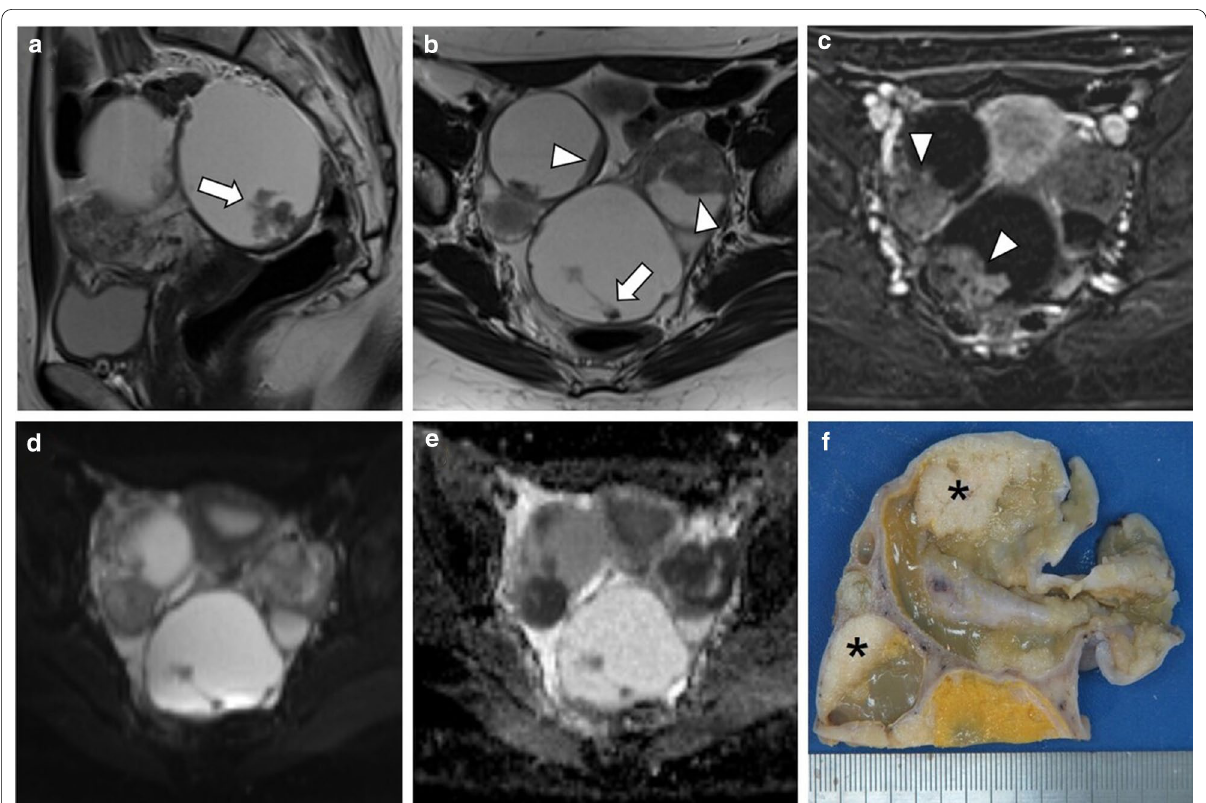
Fig. 1 Bilateral LGSC associated with SBT and peritoneal metastases in a 33-year-old female. Sagittal and axial T2-weighted MR images ( a , b ) and axial post-contrast subtraction image ( c ) display a bilateral biloculated ovarian tumour, with papillary projections (arrows), that probably correspond to SBT component, and significant solid aspects (arrowheads) presumably attributable to LGSC component. Axial b -1000 s/mm 2 diffusion-weighted image ( d ) and ADC map ( e ) show diffusion restriction in solid components. Gross section of surgical specimen of the left tumour ( f ). The ovary is replaced by a multicystic tumour with solid white nodules, corresponding to areas of LGSC (*). Small papillary projections were occasionally a component of